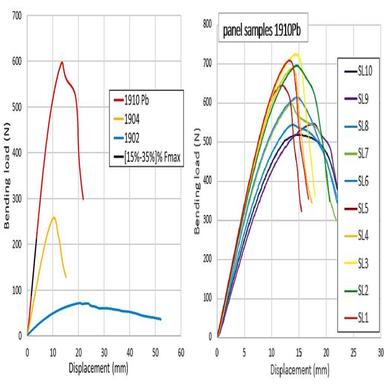
Representative example of the behavior curves of corrugated panels and measurements of their properties, as well as the behavior curves of ten 1910Pb panel samples under longitudinal bending loading.